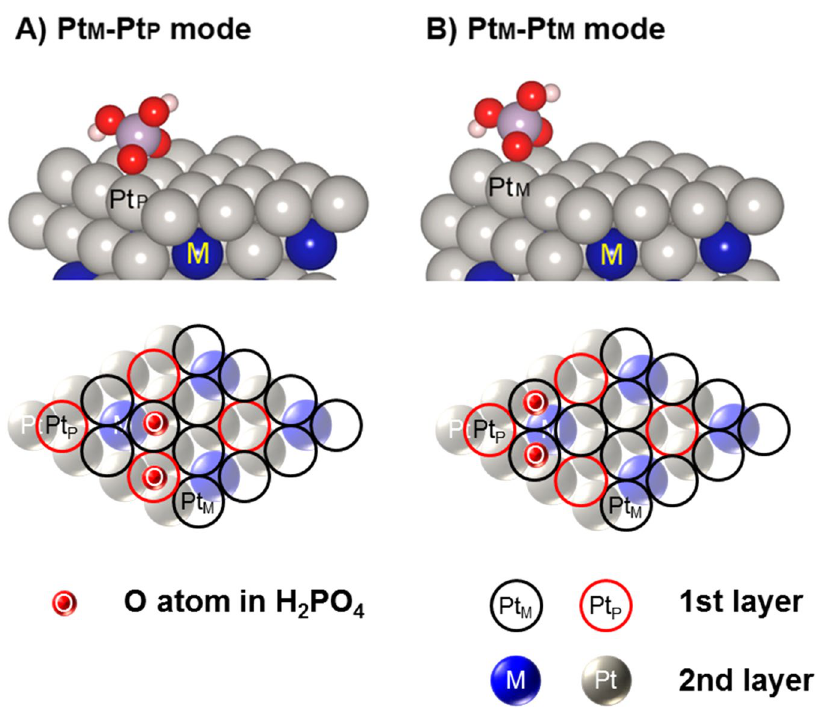
Figure 5. Structure of adsorption sites. ( A ) Pt M –Pt P and ( B ) Pt M –Pt M modes. Gray, blue, red, purple, and white balls indicate Pt, M (Ni, Co, Fe), O, P, and H,